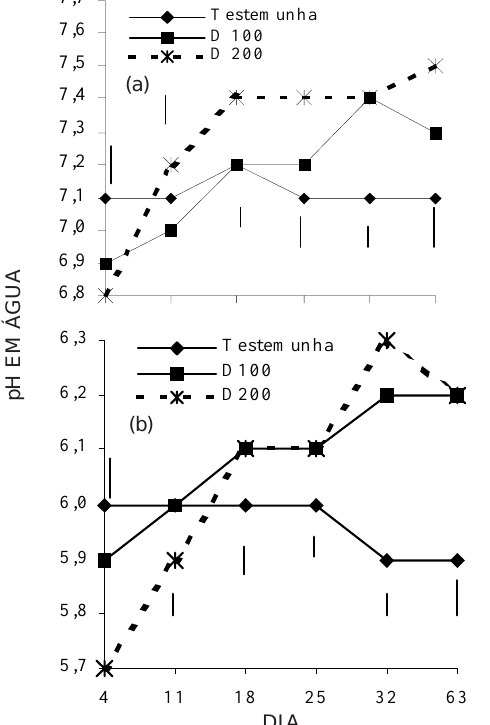
Figura 3. Valores de pH em água nos solos (a) Terra Roxa Estruturada e (b) Latossolo Vermelho- Amarelo, incubados com vinhaça e diuron. (D 100 = diuron + 100 m 3 ha -1 de vinhaça, D 200 = diuron + 200 m 3 ha -1 de vinhaça). As barras indicam a diferença mínima significativa (DMS) pelo teste t a 0,05 de